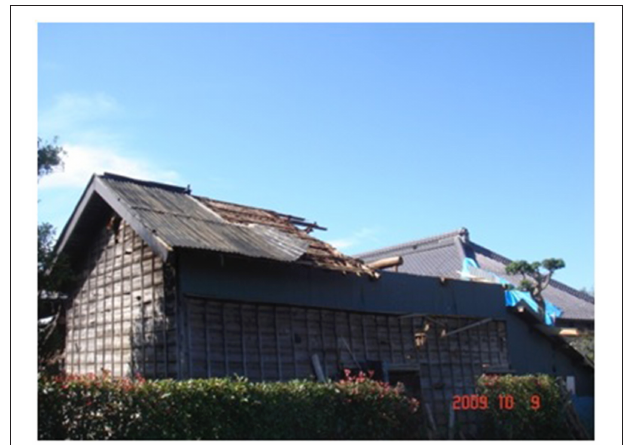
FIGURE 1 | Roof sheathing removed after a tornado in Tsuchiura, Ibaraki,